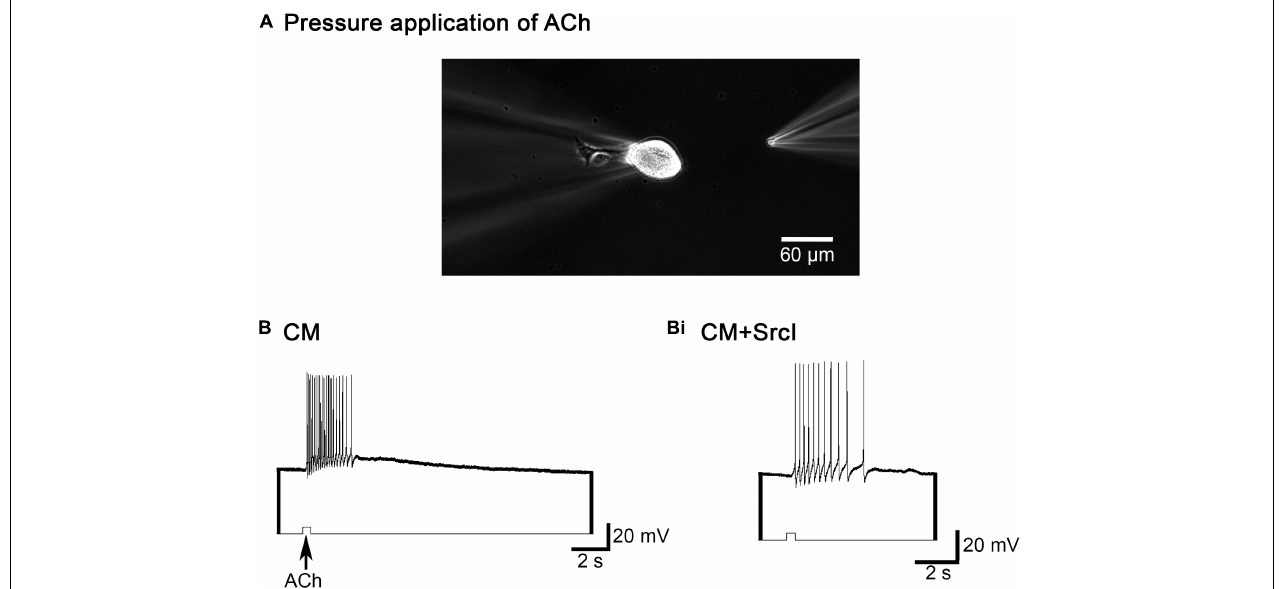
FIGURE 2 | SrcI does not affect the response of left pedal dorsal 1 (LPeD1) (postsynaptic) to acetylcholine (ACh). (A) Experimental preparation. Phase contrast image of a single LPeD1 neuron impaled by a sharp intracellular electrode at 10 × magnification. Another electrode with a tip diameter of 1–5 µ m was used to pressure apply ACh onto the cell body of LPeD1. (B) Single LPeD1 neurons were cultured in conditioned media (CM) and impaled with intracellular electrodes. Exogenous application of ACh (10 − 6 M) triggered an excitatory response in the postsynaptic neuron, LPeD1 ( n = 18). (Bi) Exogenous application of ACh also induced an excitatory response in LPeD1 neurons treated with SrcI ( n = 12; 5 µ M).